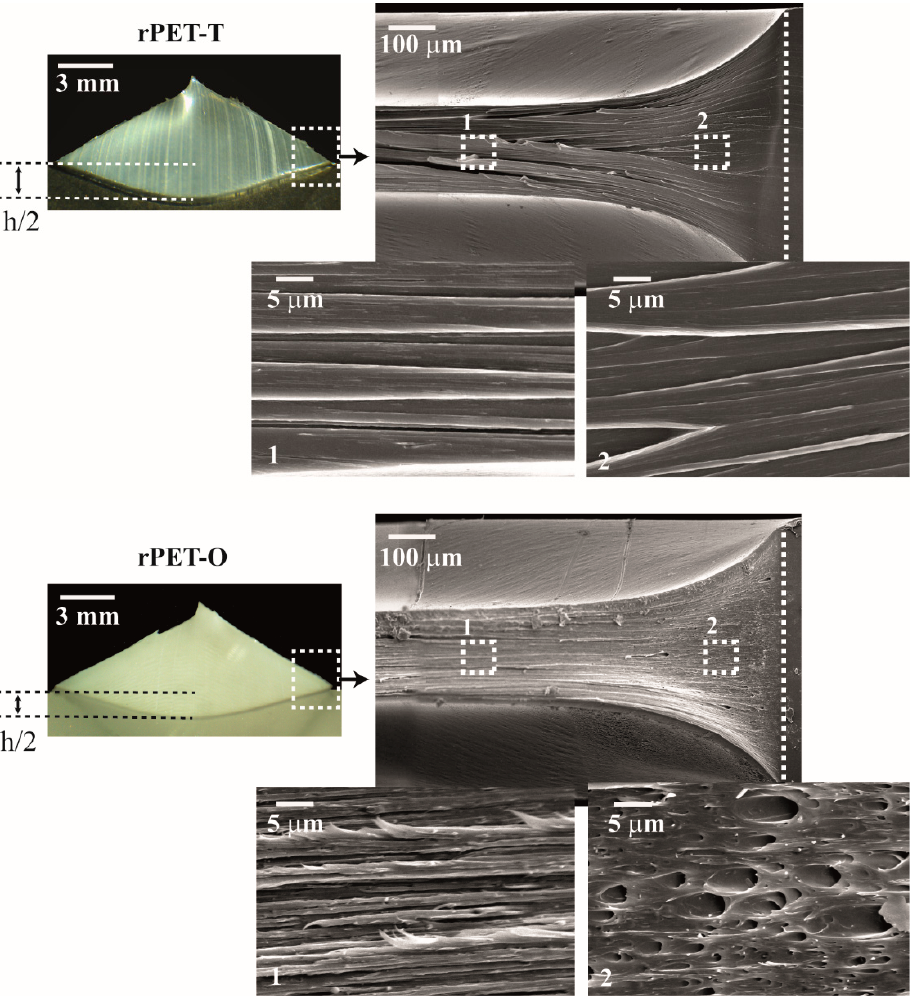
Figure 8. Micrographs taken from the plastic deformation zone of the broken unaged DDENT samples. h corresponds to the height of the plastic deformation zone. The fractured surface ahead of the crack tip (white dashed rectangle) was observed by SEM. The white dashed line indicates the initial crack tip.